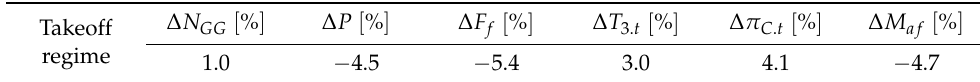
Table 9. Percentage difference